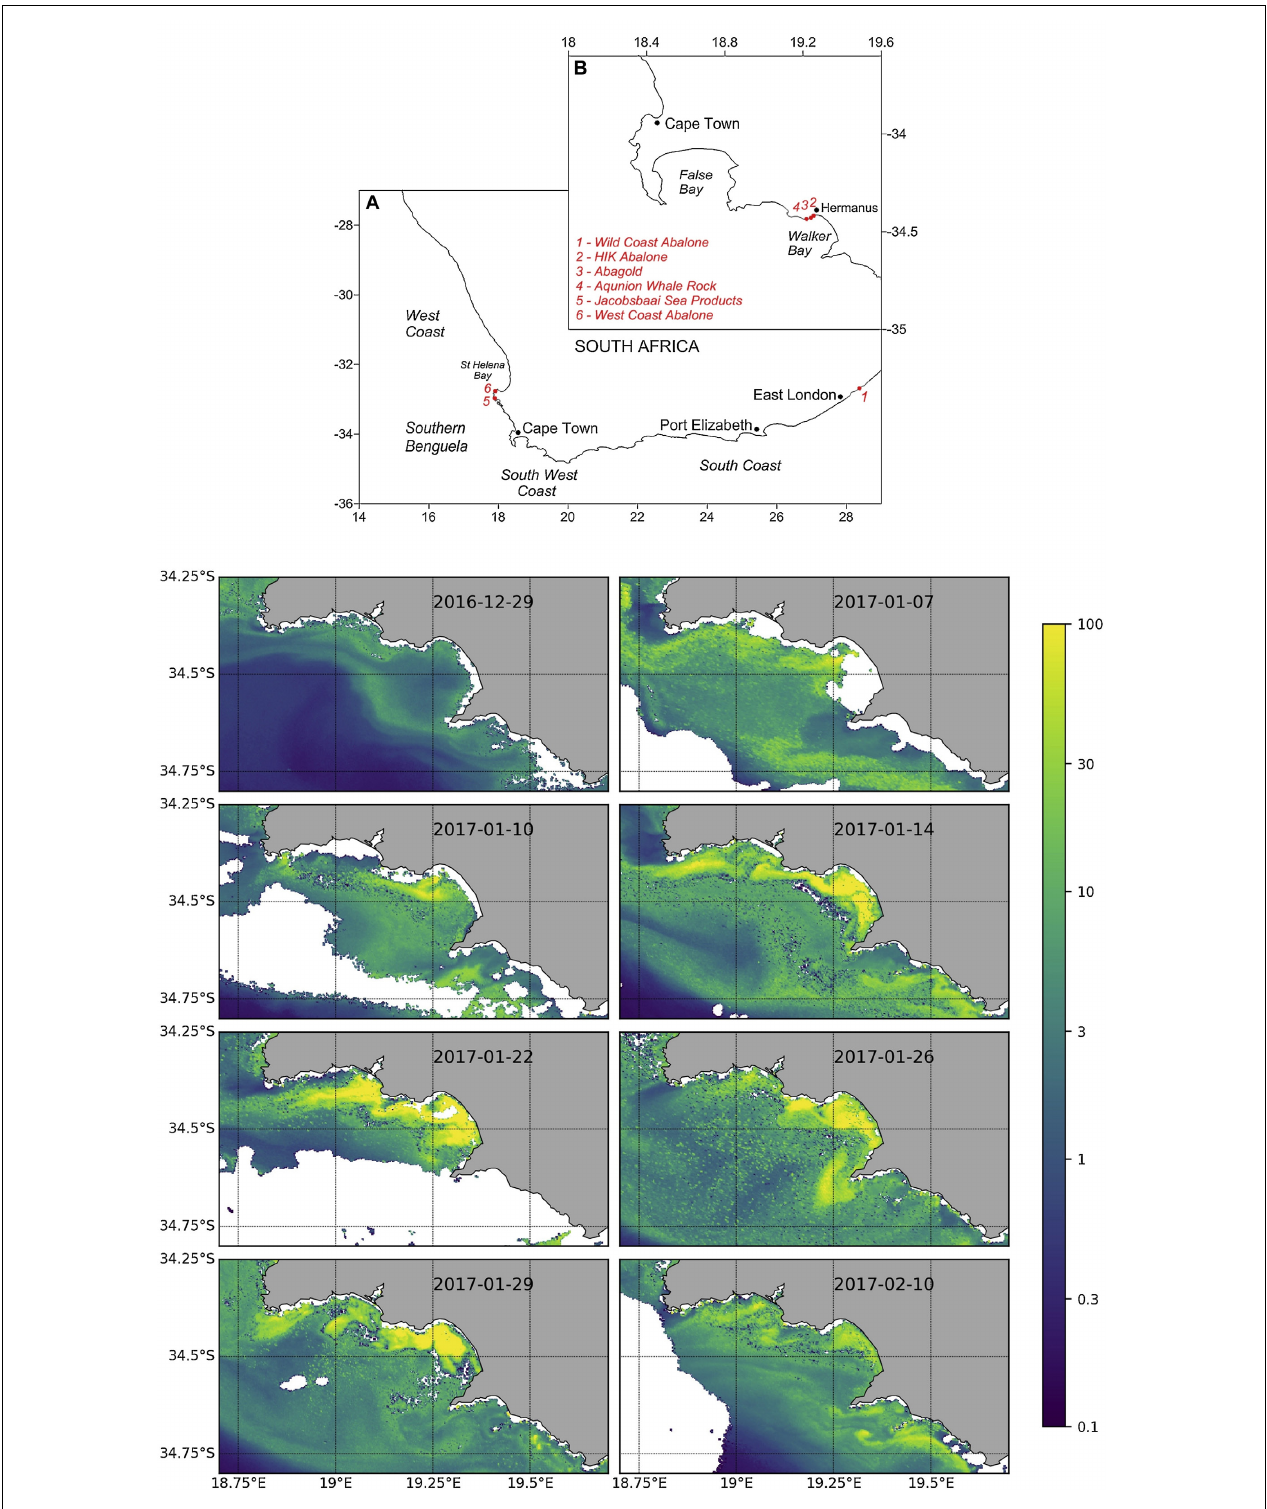
FIGURE 5 | (A,B) Map depicting the location of abalone farms on the South African coastline; lower panel shows satellite-derived chl-a concentration (in mg m-3) from the OLCI sensor for the Walker Bay area between the 29th of December 2016 and the 10th of February 2017. White areas represent either cloud or chl-a algorithm failure (Pitcher et al.,